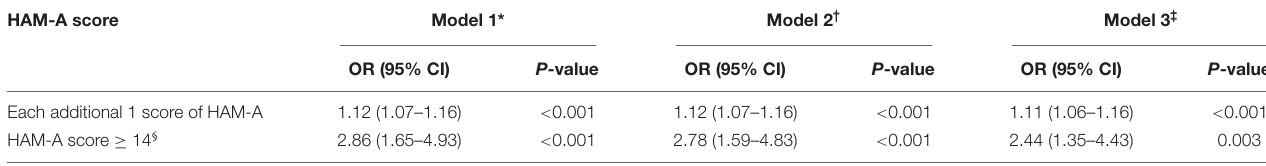
TABLE 3 | Logistic regression associations of HAM-A score as continuous and categorical variables with LVH. HAM-A score